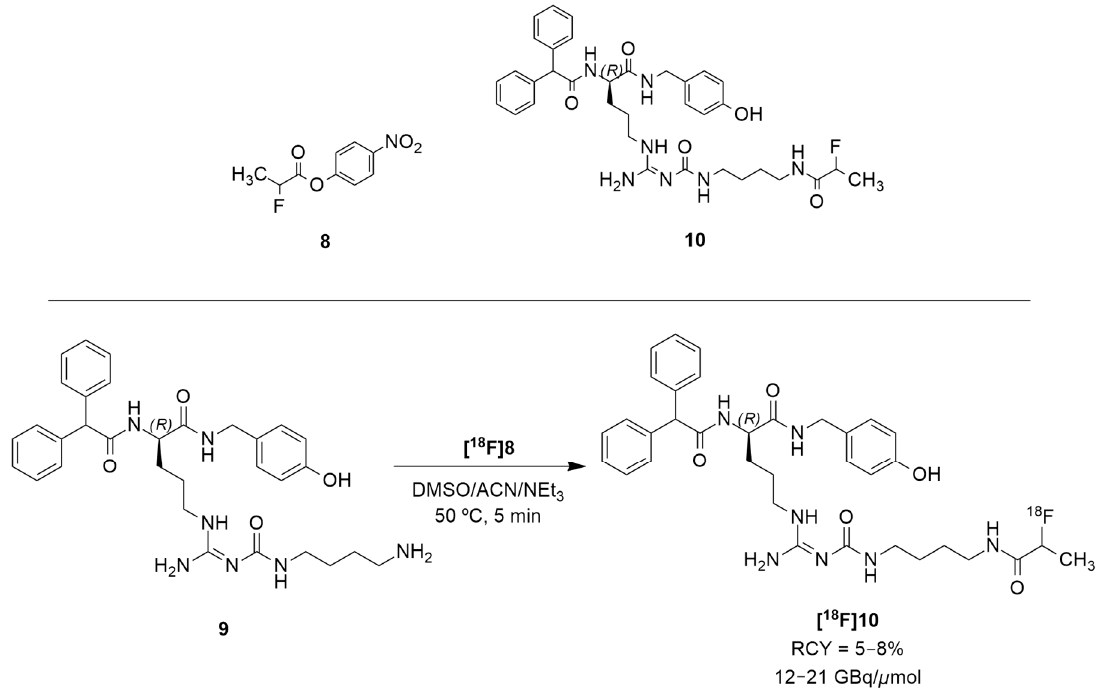
Figure 5. Radiosynthesis of [ 18 F]10